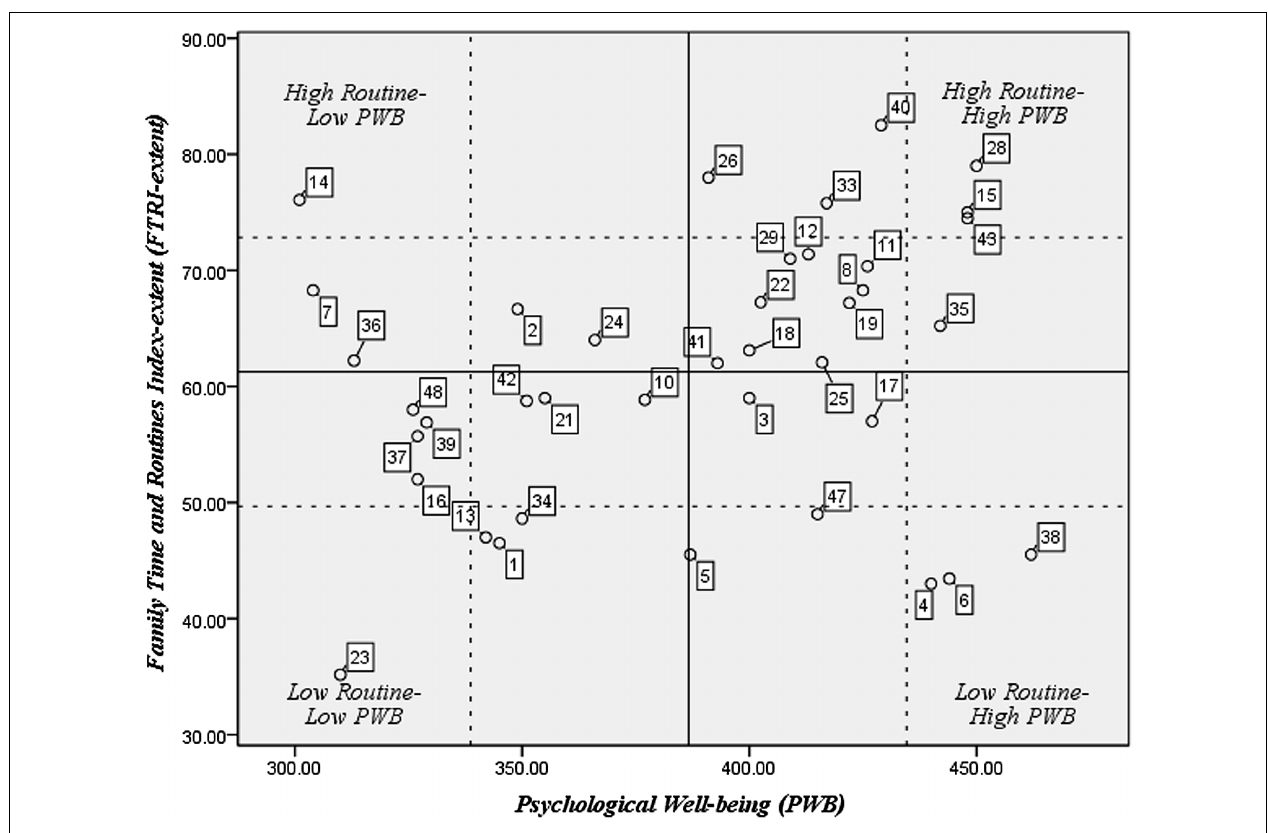
FIGURE 1 | Participants grouped by FTRI-extent and PWB scores. Solid lines indicate means of PWB or FTRI ( FTRI -extent M = 61.25; PWB M = 386.63). Dashed lines indicate one standard deviation above and below the means ( FTRI-extent SD = 11.58; PWB SD = 48.00). Squares indicate participants’ assigned